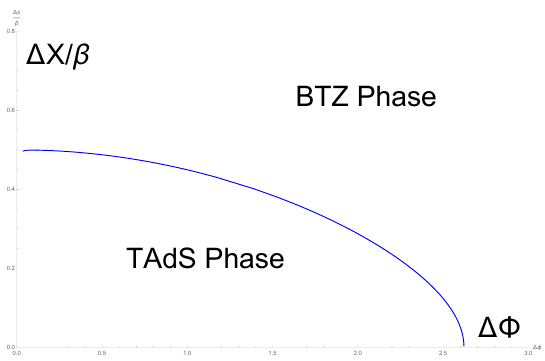
Figure 27 . We plotted the phase diagram, where the horizontal and vertical axis correspond to ∆ φ and ∆ x , β